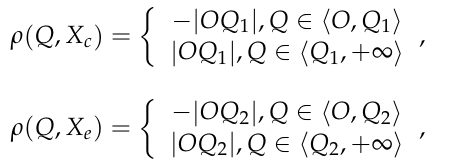
Figure 8. 1-D extension set.